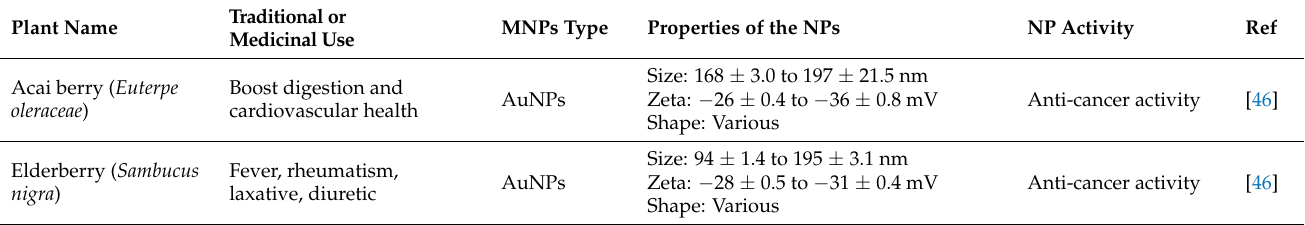
Table 1. Summary of plant-synthesized MNPs explored by BRN and collaborators for various